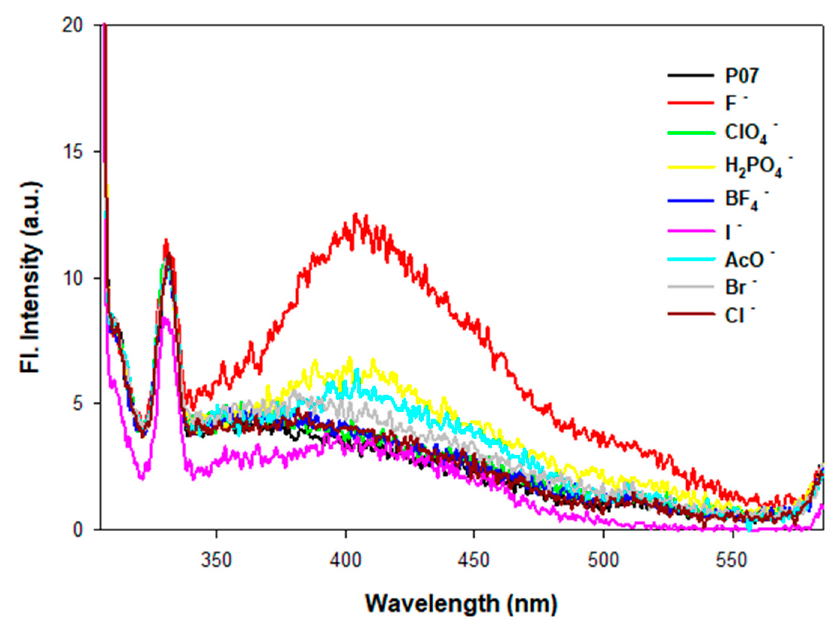
Figure 4. Fluorescence spectra of P07 (0.1 mol% P03 , solvent: toluene) treated with TBA salts (3.88 × 10 − 5 M, stock solution solvent: acetonitrile). Excitation at 300 nm. Volume of P07 solution = 2.5 mL.